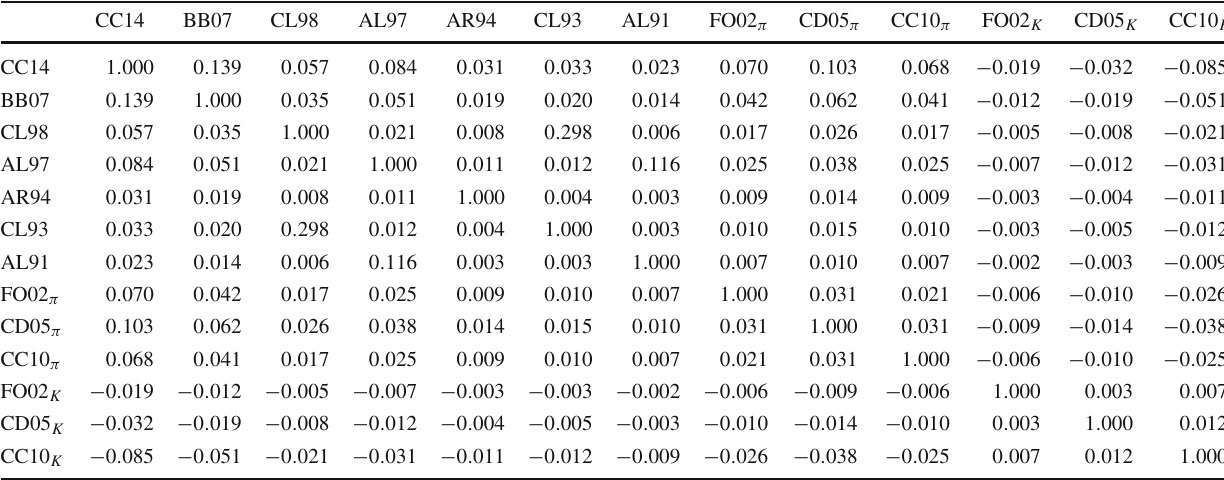
Table 287 The correlation matrix corresponding to the full covariance matrix. Subscripts h denote which of the D 0 → h + h − decay results from a single experiment is represented in that row or